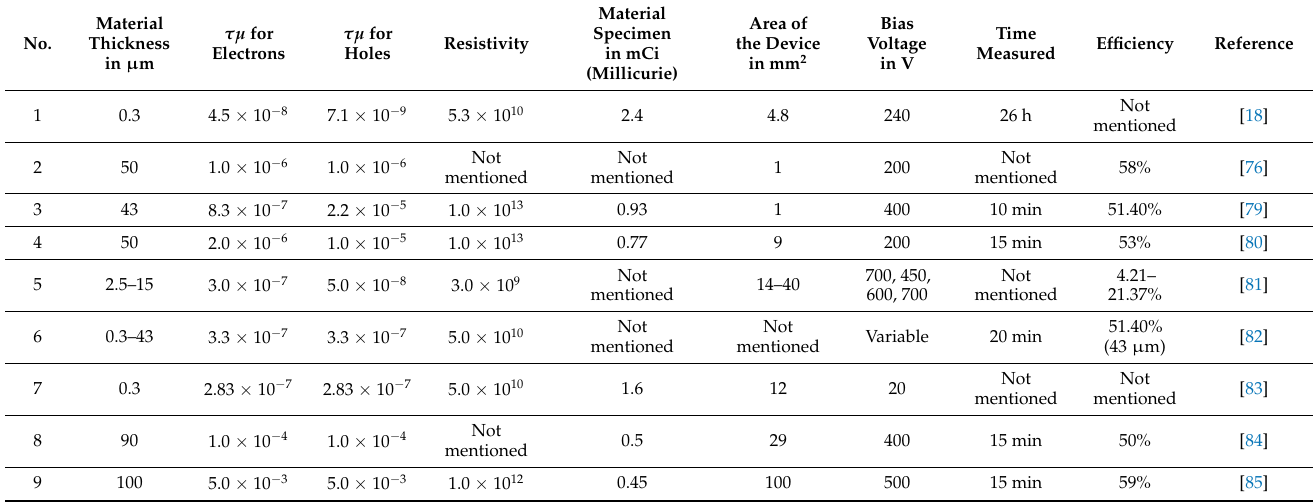
Table 6. Summary of the results found in different